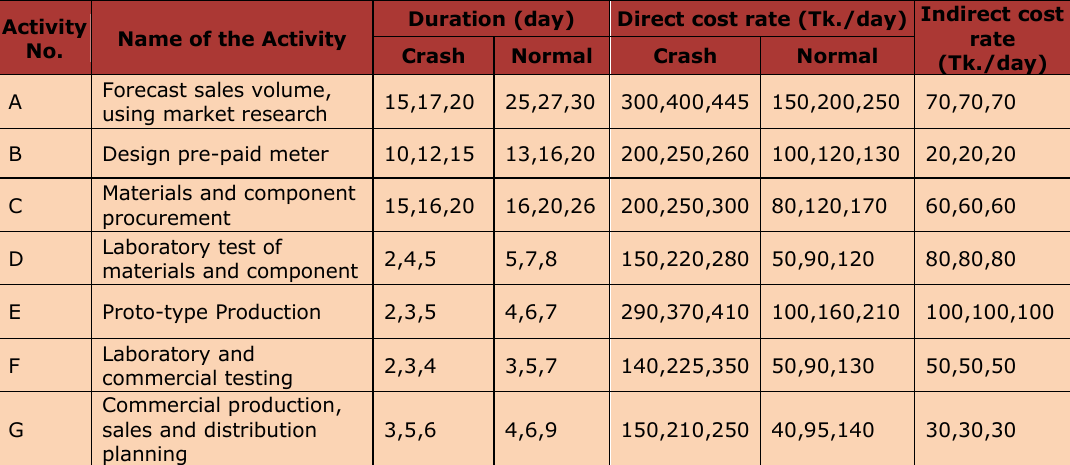
Table 1. Durations and cost rates of activities of the project on new product Pre-paid electric meter,